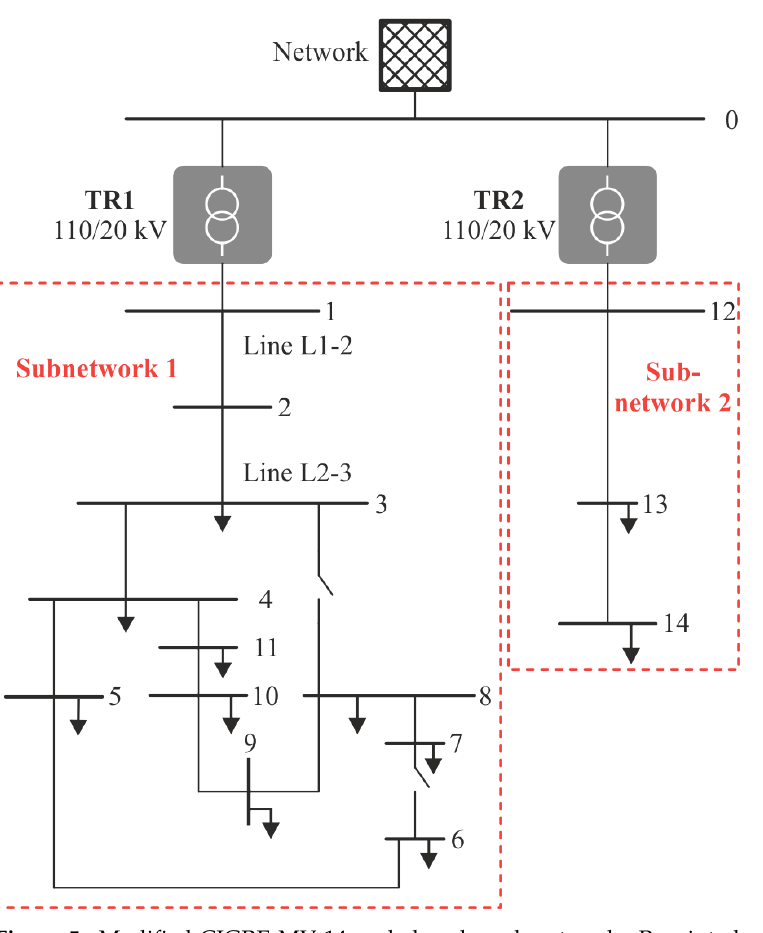
Figure 5. Modified CIGRE MV 14-node benchmark network. Reprinted with permission, from Ref. [36]. © 2006 IEEE.